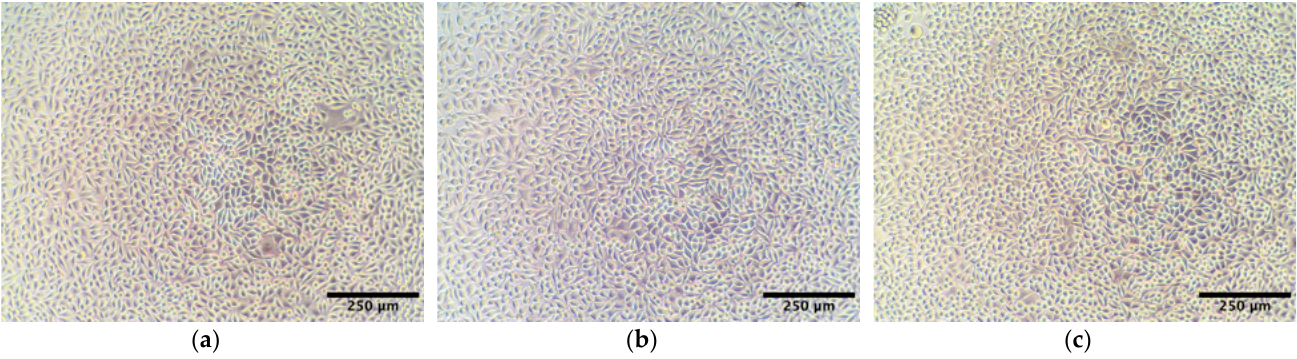
Figure 4. Morphology of L929 cells of non ‐ treated cells ( a ) and incubated with AlgL (250 μ g/mL) for 24 h ( b ) and 48 h ( c ).